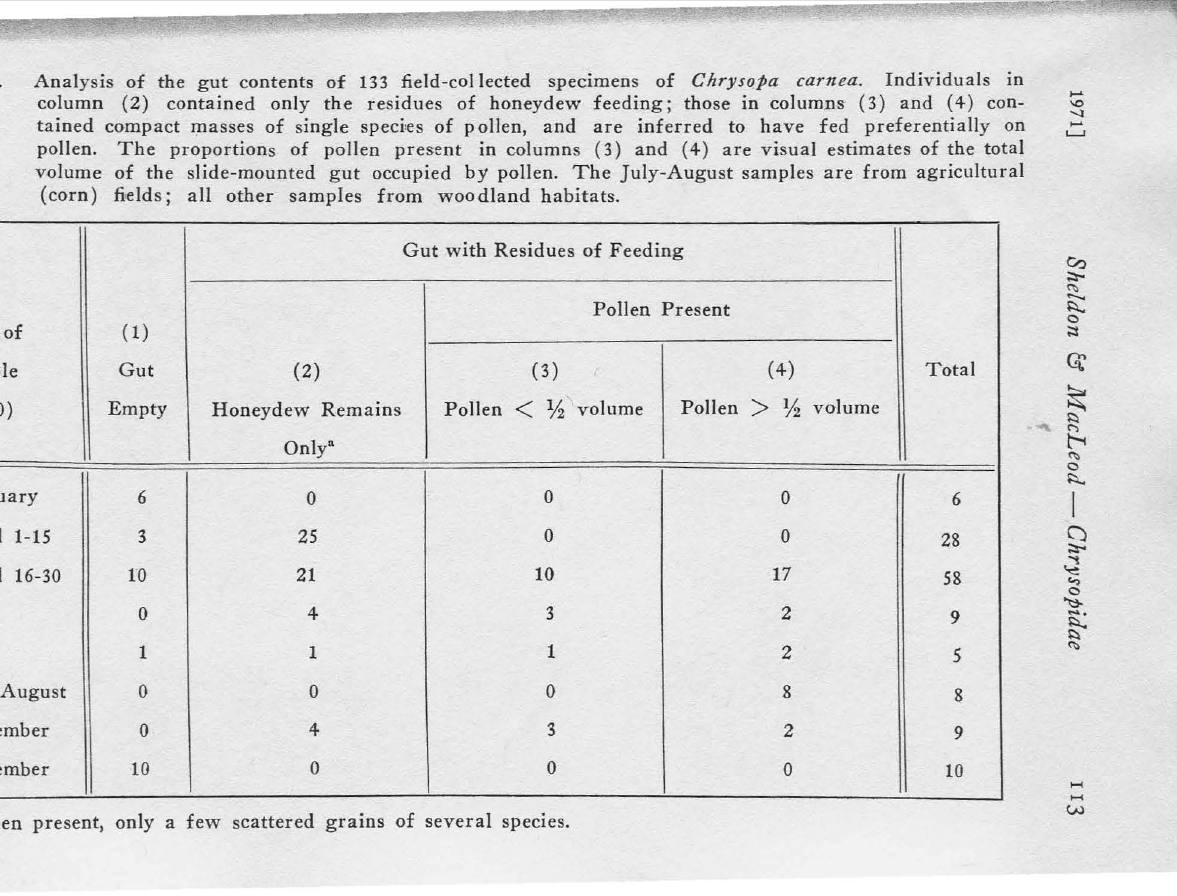
Analysis of the gut contents of 133 field-collected specimens of Chrysqpa carnea. Individuals in column (2) contained only the residues of honeydew feeding; those in columns (3) and (4) con tained compact z:nasses of single speci,es of pollen, and are inferred to have fed preferentially on pollen. The proportions of pollen present in columns ( 3) and ( 4) are visual estimates of the total volume of the slide-mounted gut occupied by pollen. The July-August samples are from agricultural (corn) fields; all other samples from woodland habitats. Gut with Residues of